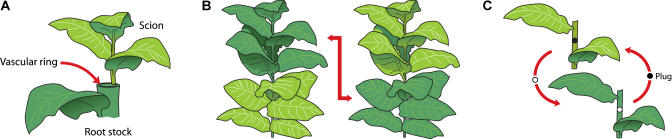
Grafting Method May Influence the Spreading Efficiency of the Silencing Signal (According to Crete et al. 2001)(A) Top grafting, the most effective in transmitting the silencing signal. (B) Reciprocal transverse graft. (C) Plug graft.